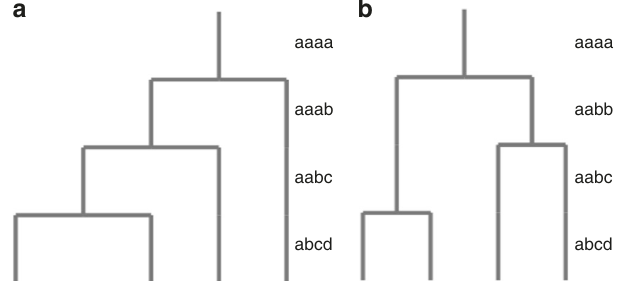
Fig. 2 Autotetraploid and allotetraploid topologies. a The autotetraploid topology, notated as (, (, (, ))); in Newick notation, corresponds to the